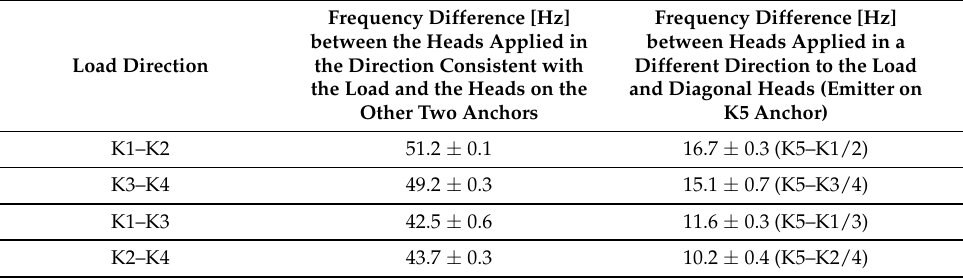
Table 4. Frequency change of SAS system for main and diagonal